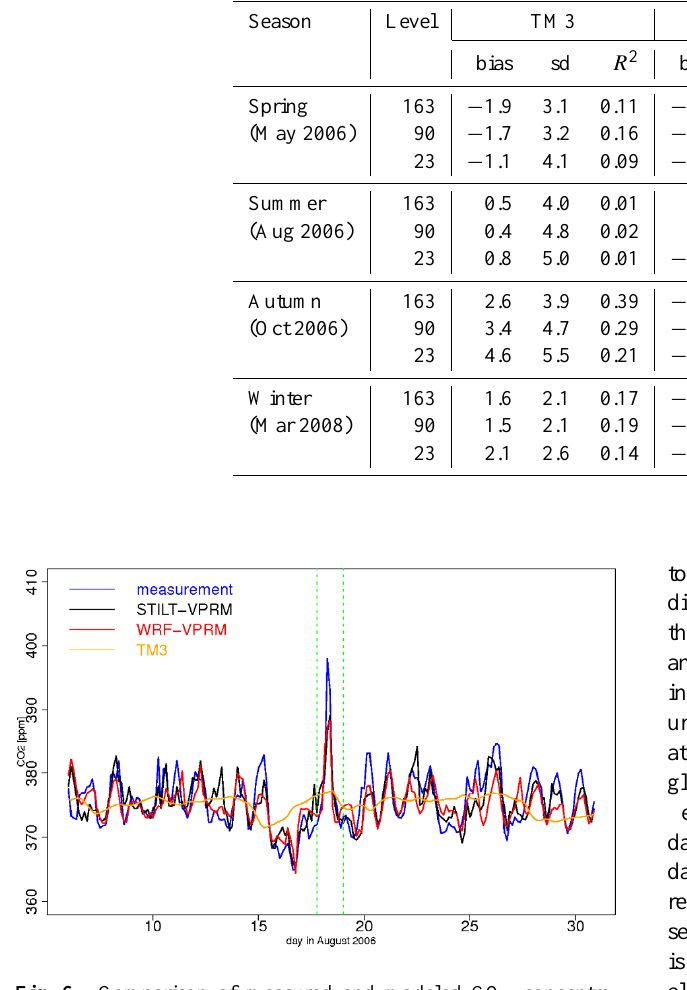
Figure 6. Comparison of measured and modeled CO 2 concentrations for August 2006 at Fig. 6. Comparison of measured and modeled CO 2 concentra- 90 m on the OXK. A period between dashed green vertical bars denotes a synoptic event tions for August 2006 at 90m on the OXK. A period between during 0 to 15 UTC on 18 th August 2006 (see also Sect. 4.1) dashed green vertical bars denotes a synoptic event during 00:00 to 15:00UTC on 18 August 2006 (see also Sect.